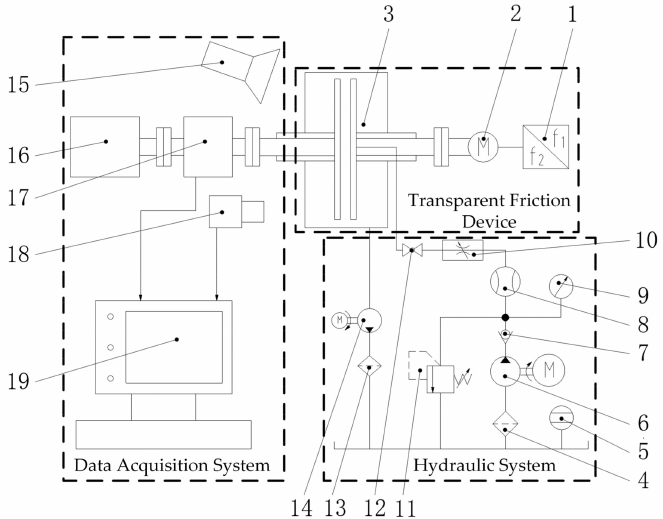
Figure 29. Transparent test system (1 = Inverter; 2 = Three-phase asynchronous motor; 3 = Transparent host; 4 = Suction filter; 5 = Liquid level meter; 6 = Quantitative gear pump; 7 = Check valve; 8 = Flow meter; 9 = Pressure gauge; 10 = Speed control valve; 11 = Relief valve; 12 = Guide-off valve; 13 = Return filter; 14 = Triangular cycloidal pump; 15 = Fill light 16 = Holding device; 17 = Torque tachometer; 18 = High-speed camera; 19 = Computer).